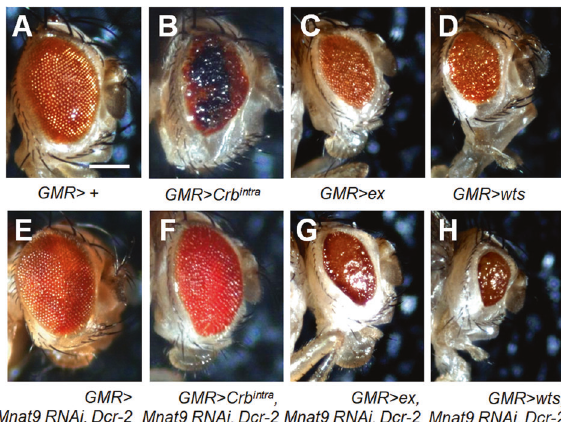
Fig. 1 Mnat9 genetically interacts with Hippo pathway compo- nents in the Drosophila eye. A Control normal eye with GMR-Gal4 . B – D Eye phenotypes caused by overexpression of the following factors using GMR-Gal4 : Crb intra ( B ), Ex ( C ), and Wts ( D ), respectively. E Mnat9 RNAi shows little defect. F – H Genetic interaction between Mnat9 RNAi and overexpressed Crb intra ( F ), Ex ( G ), or Wts ( H ). Crb intra phenotype is suppressed by Mnat9 RNAi . However, phenotypes of Ex or Wts overexpression are enhanced by Mnat9 RNAi . Scale bar: 200 μ